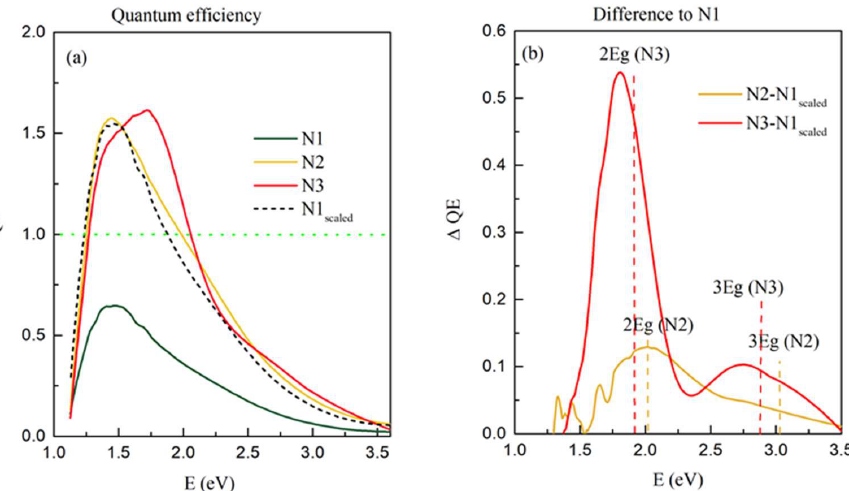
Figure 7. ( a ) Quantum efficiency of the films N1–N3. A green dashed line indicates the value of QE = 1, which corresponds to one exciton formed for one incident photon. N1 scaled represents the QE of the film N1 normalized to the maximum of the QE of the film N2. ( b ) Difference of the QE values measured for the film N2 and N3 with respect to the value of N1 scaled .Vertical dashed lines indicate the positions of 2Eg and 3Eg for films N2 and N3.